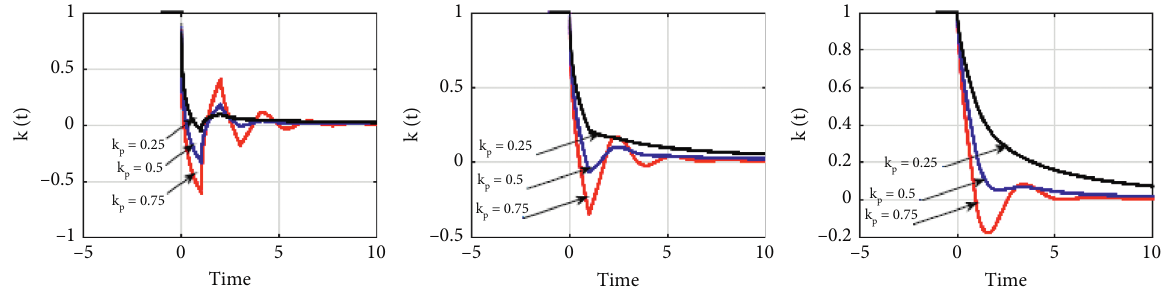
Figure 1: Stability diagrams at τ � 1 when q � 0.25, 0.5, and 0.75 from left to right, respectively ( n � m �